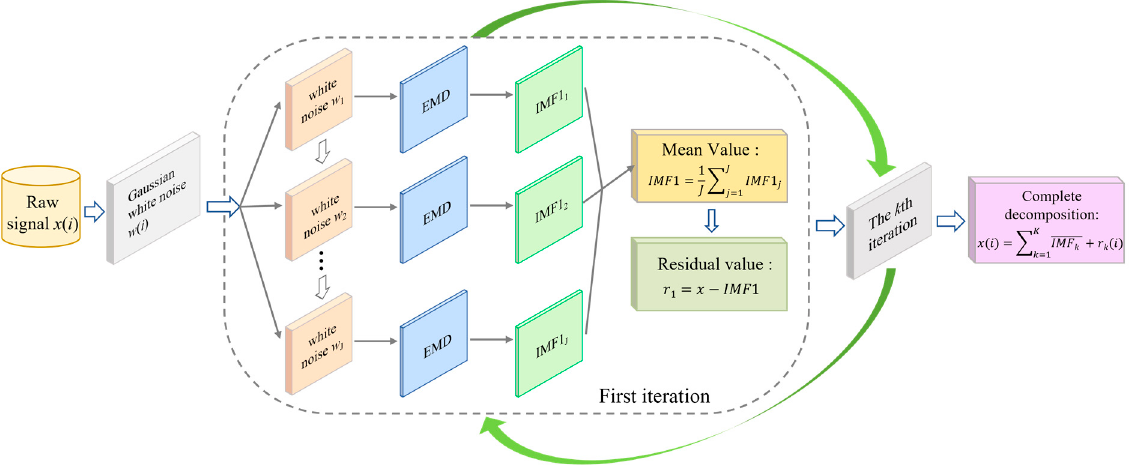
Figure 6. The CEEMDAN method flowchart.